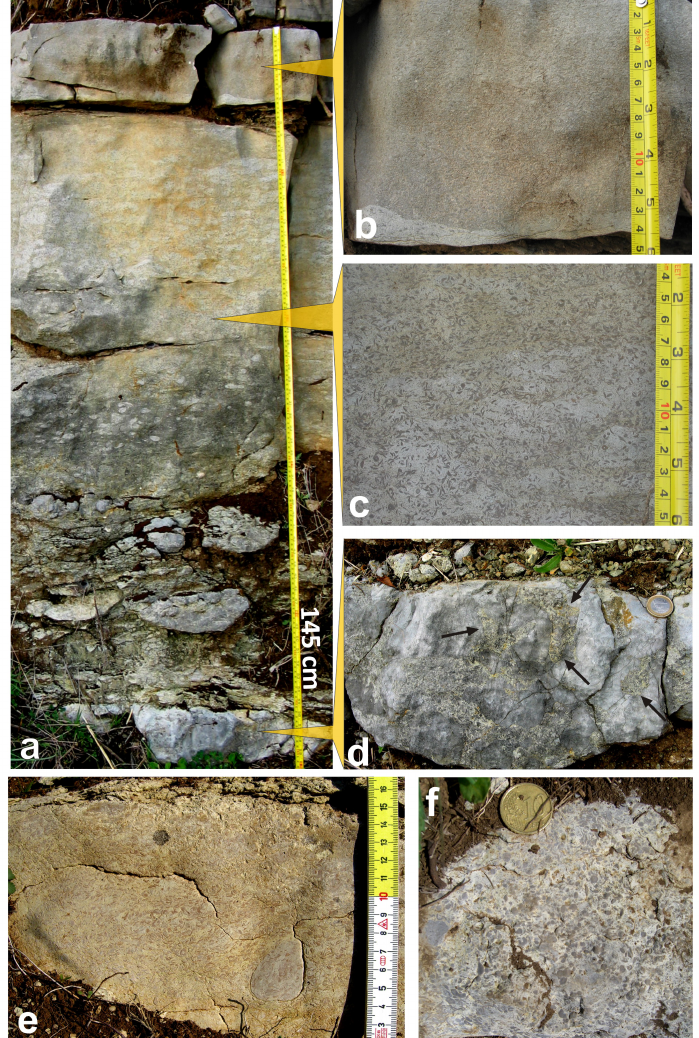
Fig. 6. The “Orbitolina level” at Mt. Tobenna (a) is made by a nodular marly basal interval followed by a marly limestone crowded with flat low-conical orbitolinids (c) . At the top there is a bed of orbitolinid-codiacean packstone/grainstone (b) . The underlying bed (d) is penetrated by a network of dissolution cavities filled by orbitolinid marly-packstone (see arrows); (e) : orbitolinid marly-packstone at Mt. Croce; (f) : orbitolinid marly-packstone at Mt.